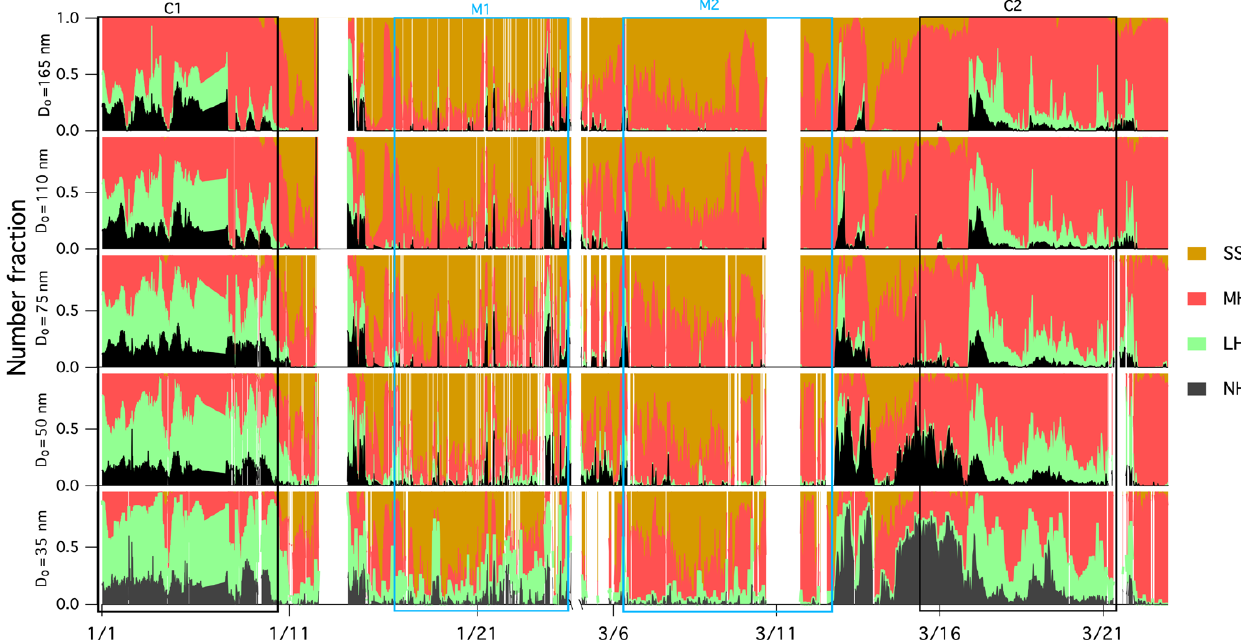
Figure 4. Time series of the number fraction of the NH mode (in black; GF < 1 . 11), the LH mode (in green; 1 . 11 < GF < 1 . 33), the MH mode (in red; 1 . 33 < GF < 1 . 85) and the SS mode in (in brown; GF > 1 . 85) of aerosols with preselected dry diameter.